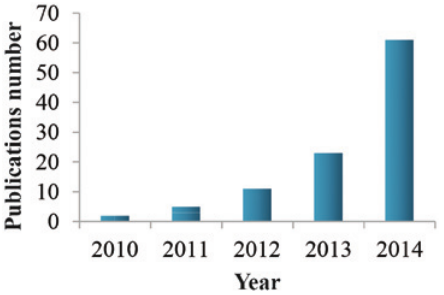
Figure 1: Evolution of the number of publications involving the use of CD-based assays for inorganic trace